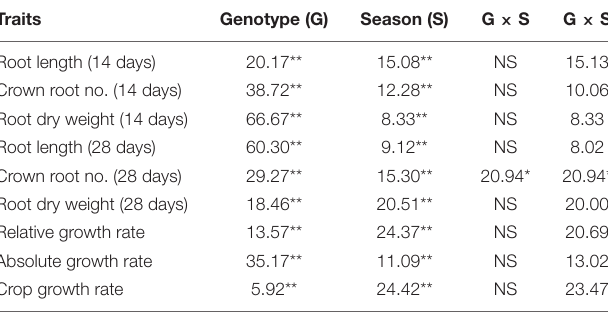
TABLE 1 | The percentage contribution of genotypes, season and genotype × season interactions for the root traits observed under direct-seeded